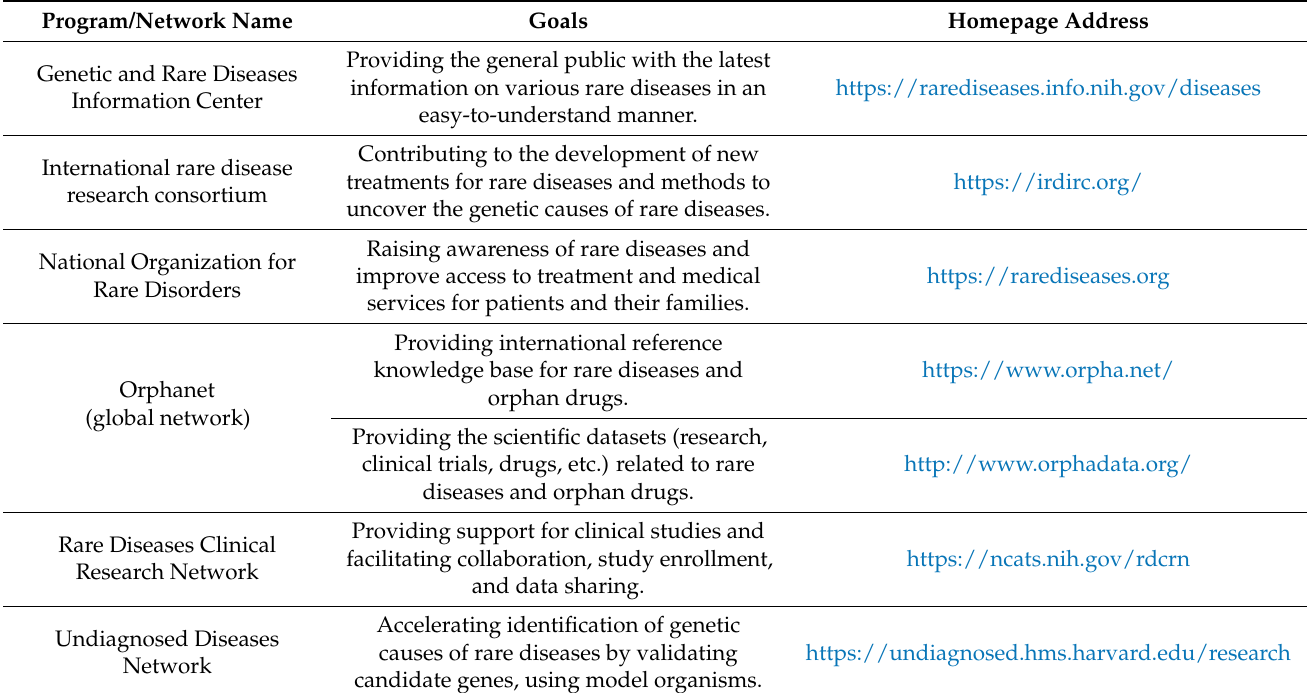
Table 1. List of rare disease research program or